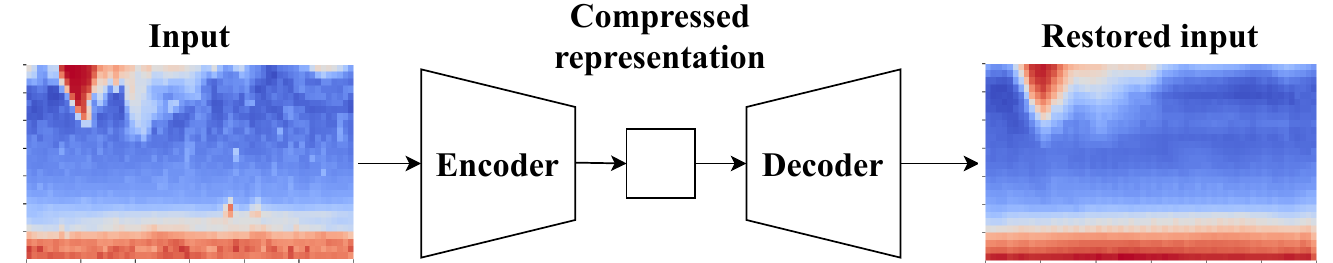
Figure 3. The architecture of an